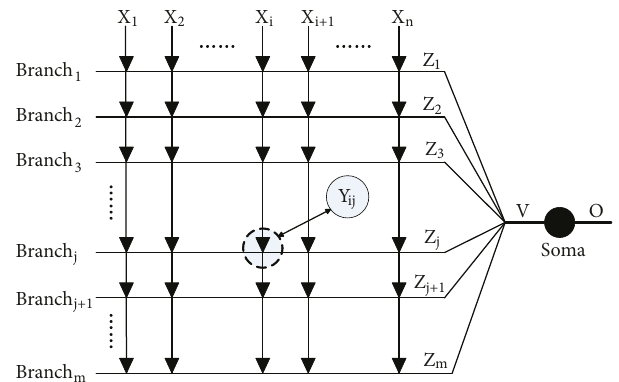
Figure 1: The morphological architecture of the